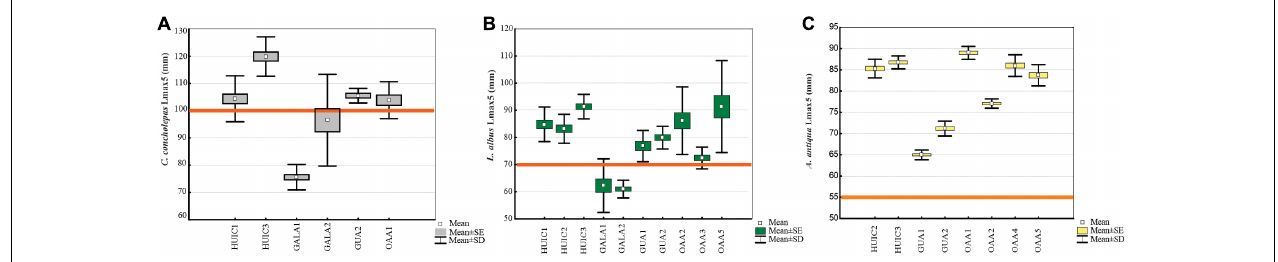
FIGURE 3 | Average size of the largest 5% (Lmax5, mm) and standard deviation (SD) of commercial species in MAs and OAAs; (A) C. concholepas, (B) L. albus, and (C) A. antiqua